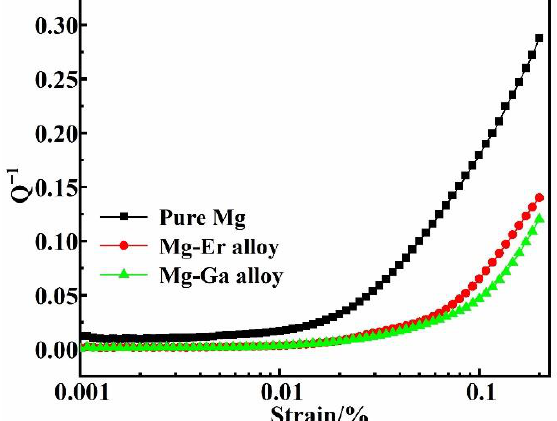
Figure 5. The damping curves of pure Mg, solid solution Mg-Ga and Mg-Er alloys. Table 3. Characteristic atomic differences between two alloying element atoms.